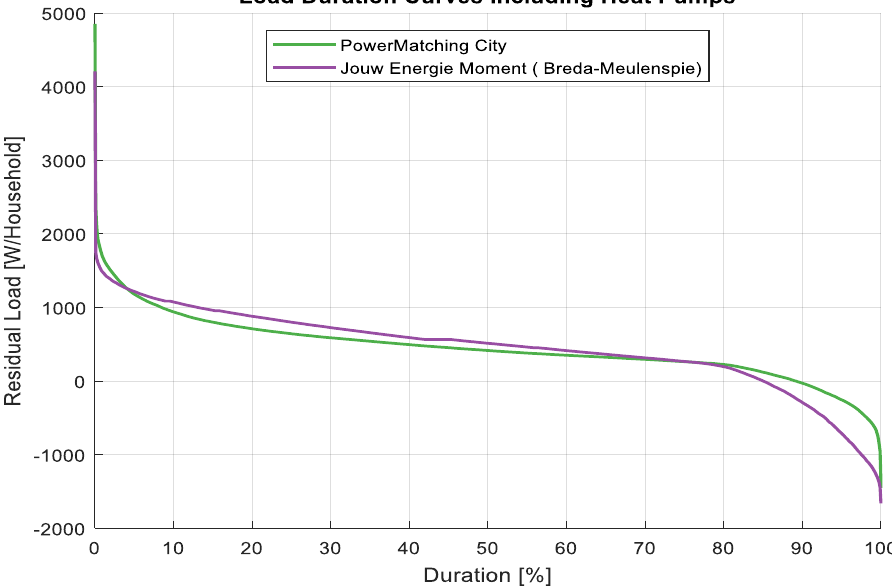
Figure 2. Load duration curves of the “ Smartgrid: Rendement voor Iedereen ” project, the Liander Zonnedael open access dataset, and the “Jouw Energie Moment” project (exclusively Breda-Easy Street).